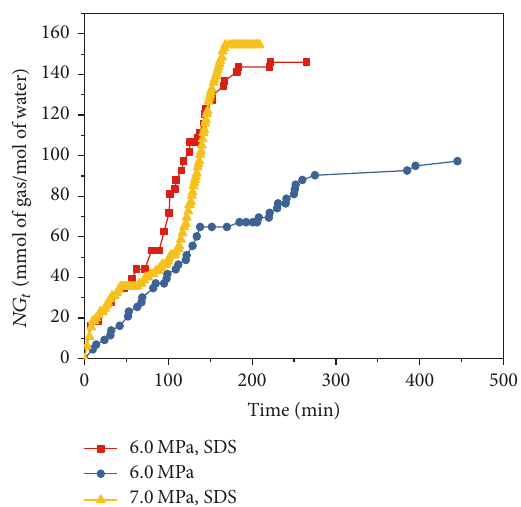
Figure 5: Methane consumed per mole of water in different condi- tion.